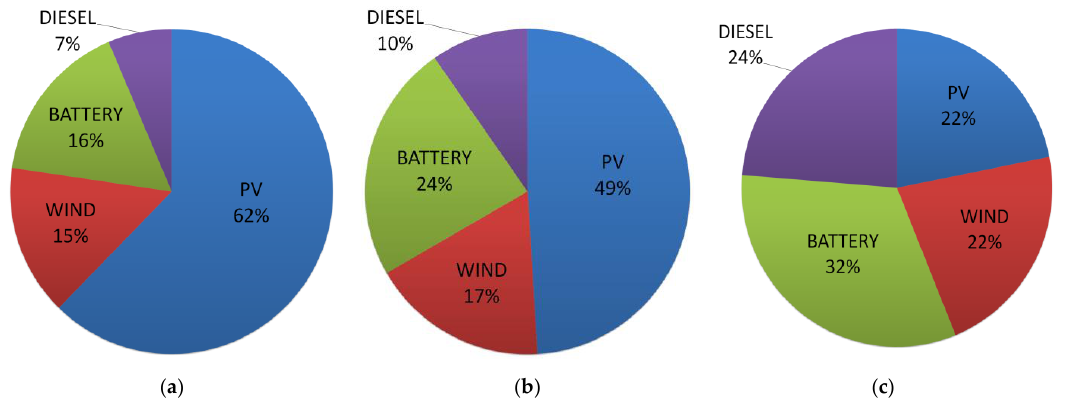
Figure 15. The annual contribution of energy generation by PV/WT/battery and DG for MOGOA. ( a ) Solution #1; ( b ) solution #10; ( c ) solution #20.